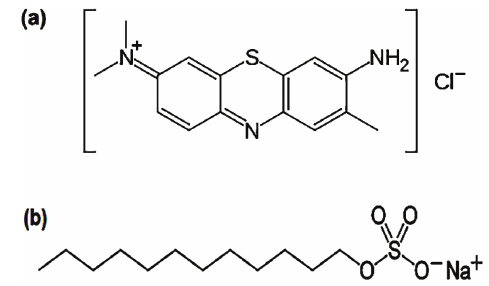
Fig. 2 – Molecular structure of tolonium chloride (a) and so - dium dodecyl sulfate